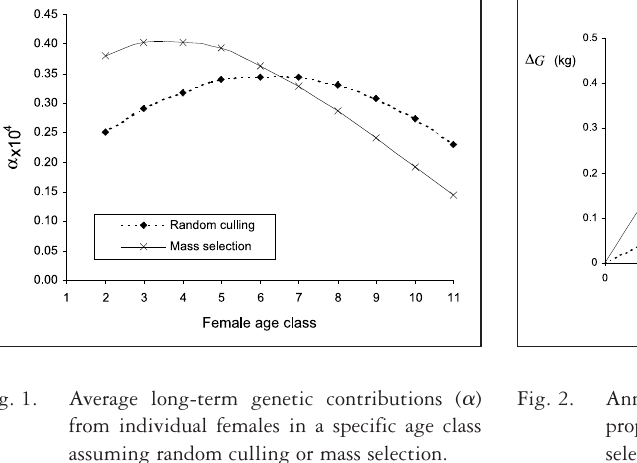
Fig. 1. Average long-term genetic contributions (  ) from individual females in a specific age class assuming random culling or mass selection.